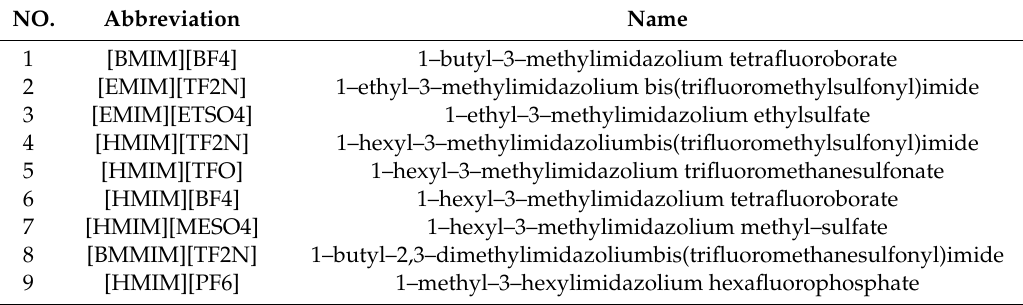
Table 2. Name and abbreviation of imidazolium ionic